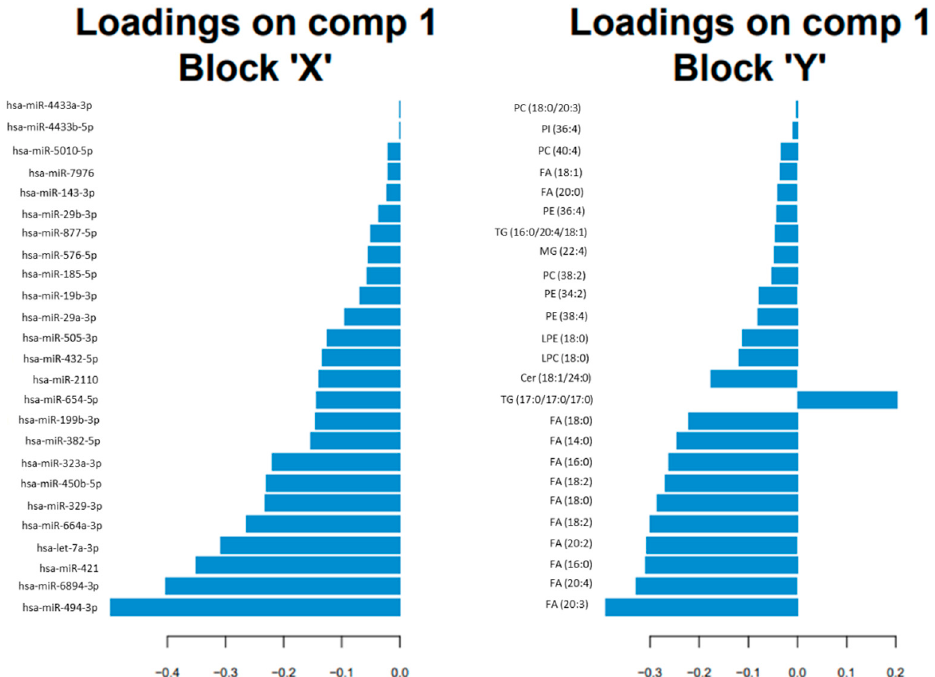
Figure 2. Horizontal barplot to visualise loading vector. The contribution of each variable for each component (comp) is represented in a barplot, where each bar length corresponds to the loading weight (importance) of the feature. The loading weight can be positive or negative.